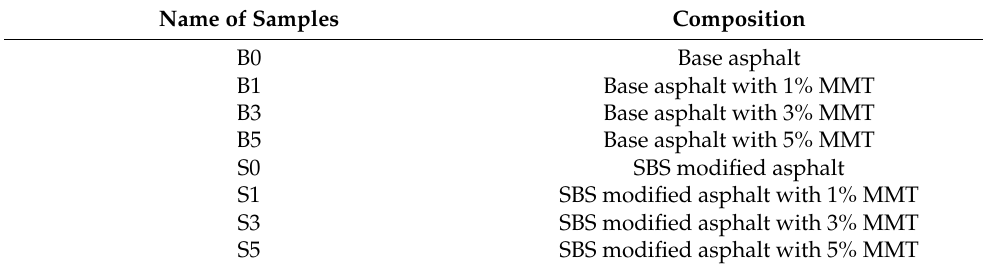
Table 4. Name of asphalt binder samples.